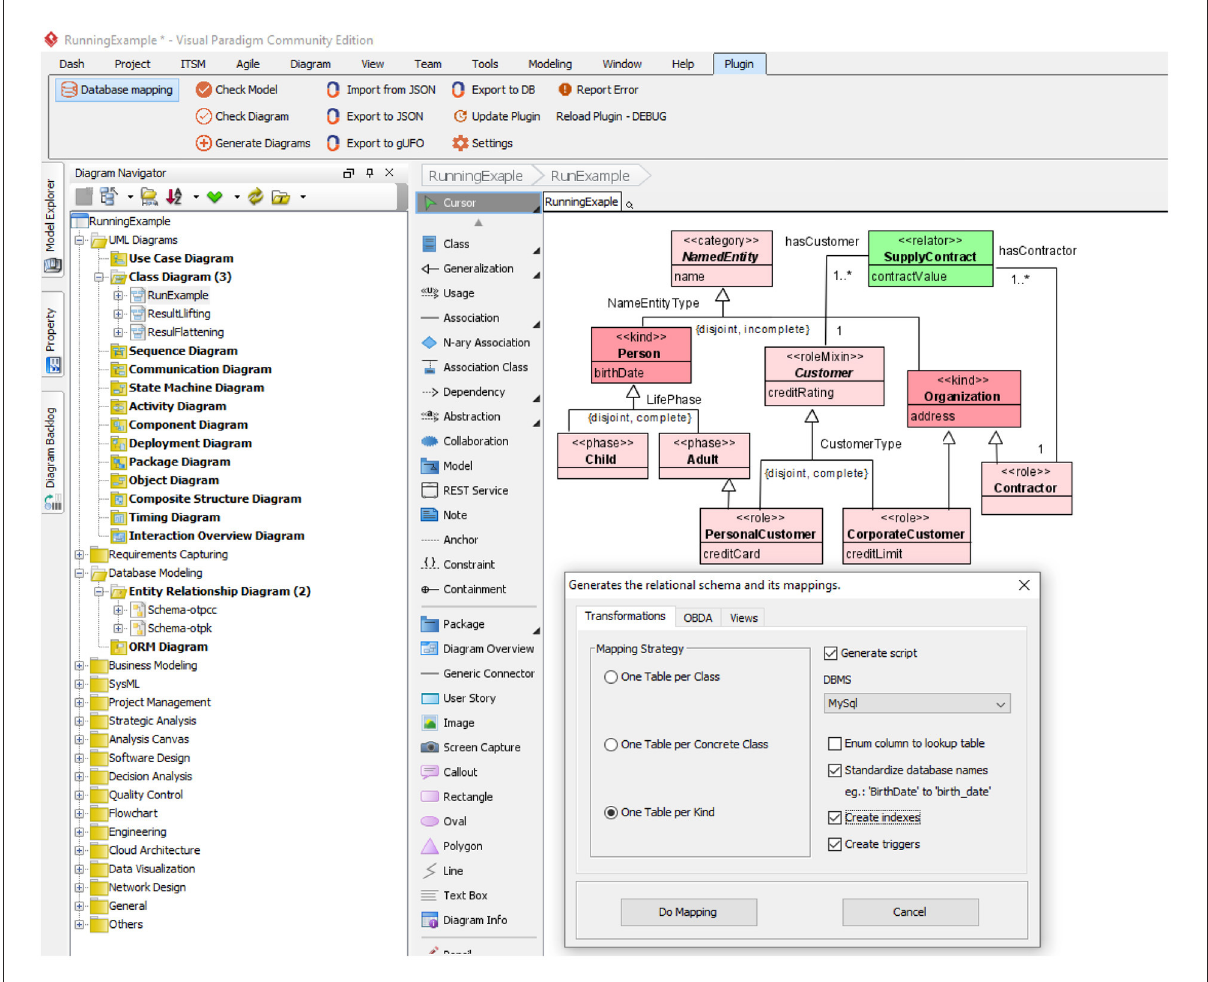
FIGURE11 A screenshot of the object-relational plugin